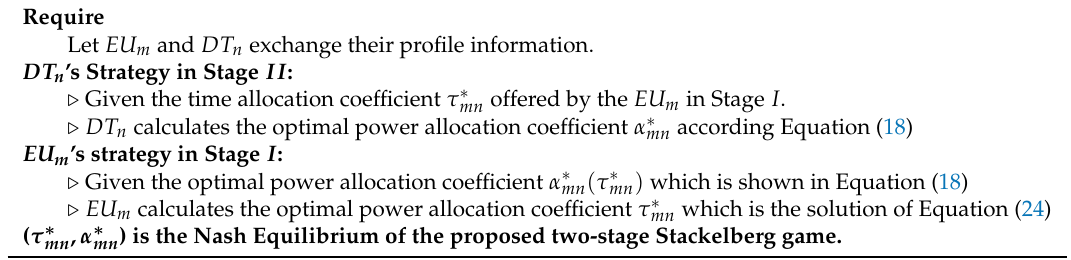
Table 2. The proposed two-stage Stackelberg game